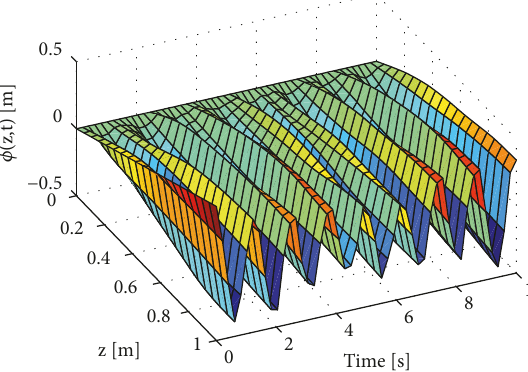
Figure 3: Rotation of the flexible link without